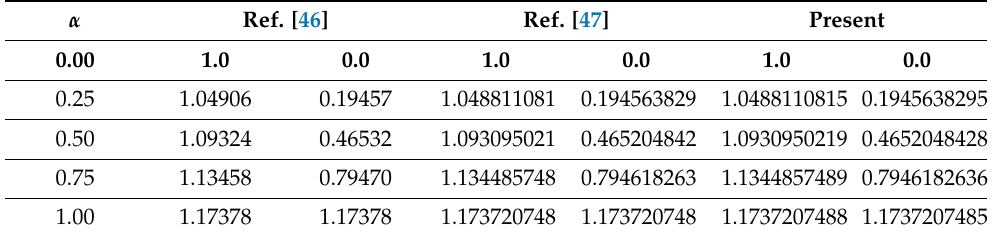
Table 6. Results comparison of local skin friction coefficients for several α values.